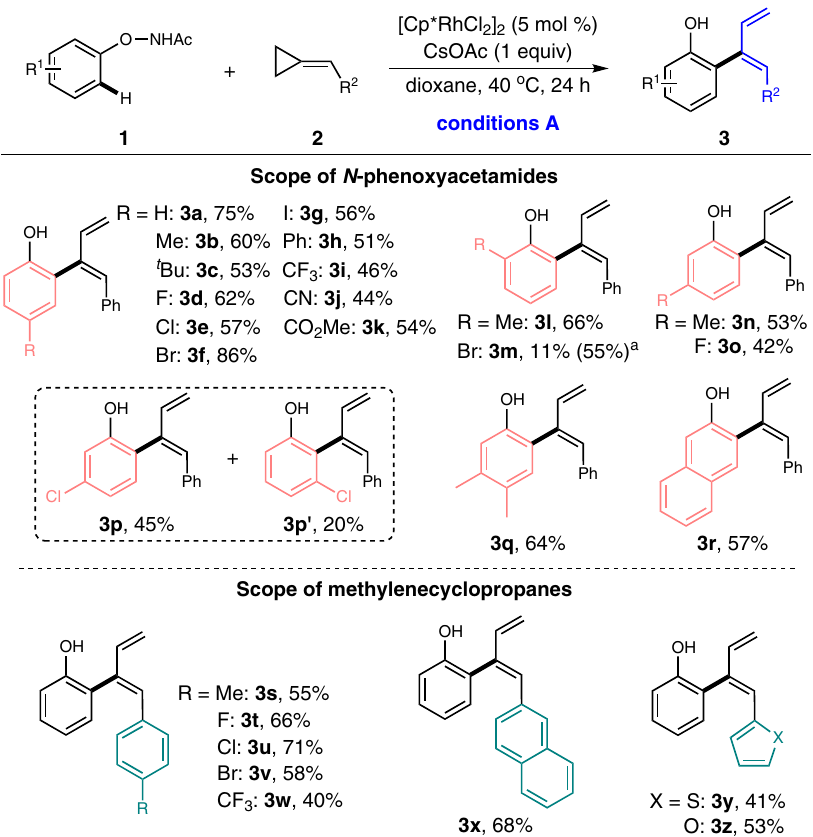
Fig. 2 Substrate scope for the synthesis of dienes. Reaction conditions A: 1 (0.2 mmol), 2 (0.4 mmol), [Cp*RhCl 2 ] 2 (5 mol%), and CsOAc (1 equiv) in dioxane (0.2 M) at 40 °C for 24 h under air; isolated yields were reported. a The reaction was conducted in MeOH (0.2 M). COMMUNICATIONS CHEMISTRY| (2021) 4:81